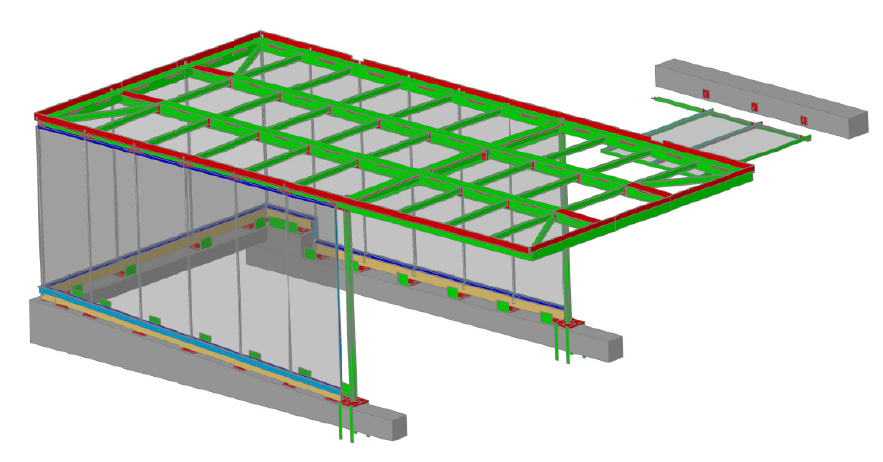
Figure 12: Design of the subway